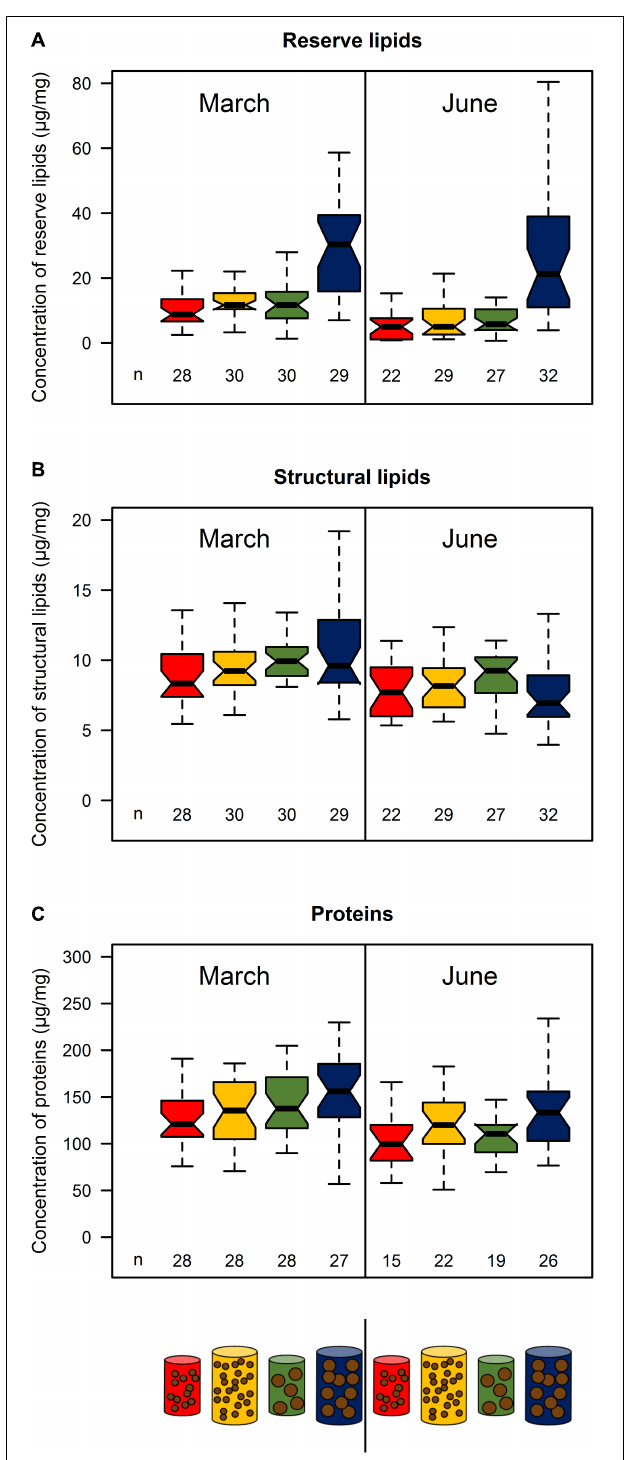
FIGURE 3 | Reserve lipids (A) , structural lipids (B) , and proteins (C) of sardine muscle from the four feeding treatments (red: pellet size of 0.1 mm and pellet quantity 0.3%; green: 0.1 mm and 0.6%; yellow: 1.2 mm and 0.1% and blue: 1.2 mm and 0.6%) in March and June 2017. Concentrations are given relative to muscle wet weight. Sample size for each treatment is given by n below the boxes. Boxplots are presented without outliers for clarity purposes.